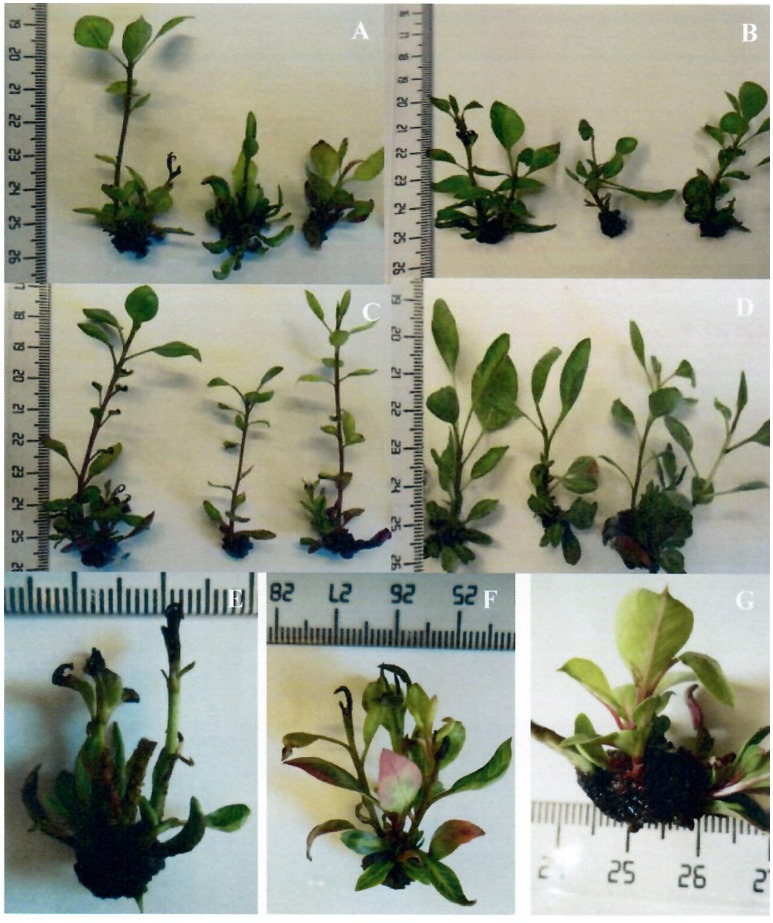
Response of pistachio rootstocks to mineral nutrients “Ghazvini” rootstock on (A) MS (control), (B) Treatment #24; “UCB1” rootstock on (C) MS (control), and (D) Treatment #24. The occurrence of some physiological disorders including (E) shoot-tip necrosis, leaf necrosis and hooked leaves in “Ghazvini,” (F) shoot-tip necrosis in “UCB1”and (G) basal callus in “UCB1”.